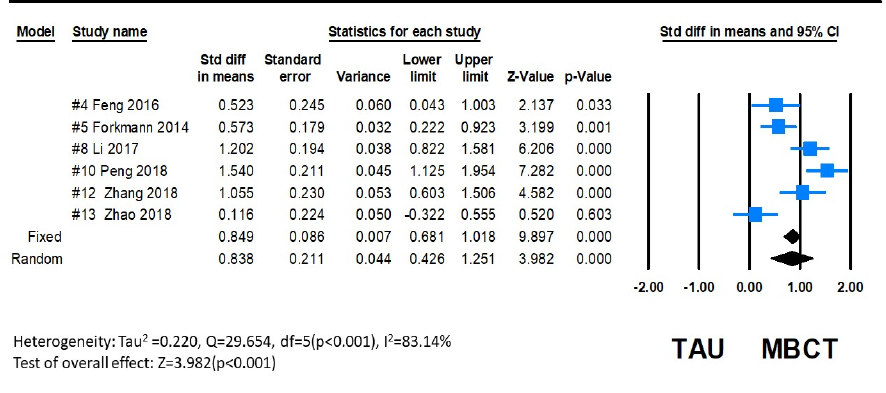
Figure 7. Forest plot of HAMD effect of MBCT on depression.